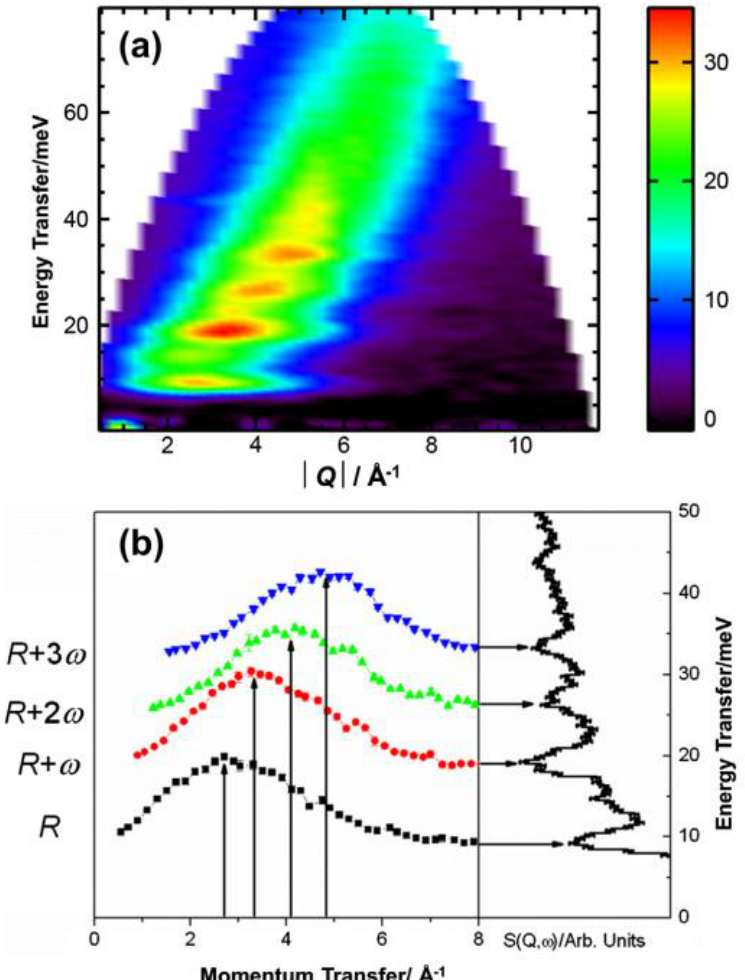
Figure 4. ( a ): The S ( Q , E ) map of hydrogen for 1(p-H2):Cu in HKUST-1 for an incident energy of 75 meV measured using the MARI spectrometer. The green broad intensity ribbon is due to the translational quantum dynamics of H 2 and corresponds to the associated broad intensity ribbon shown in the preceding Figure 3. ( b ): Series of cuts along momentum transfer at a series of energy transfers corresponding to the intensity peaks shown in the right panel, i.e., the integrated (over momentum transfer) intensity for along energy transfer for the S ( Q , E ) map shown in panel ( a ). (Reproduced from [29], with permission of Elsevier